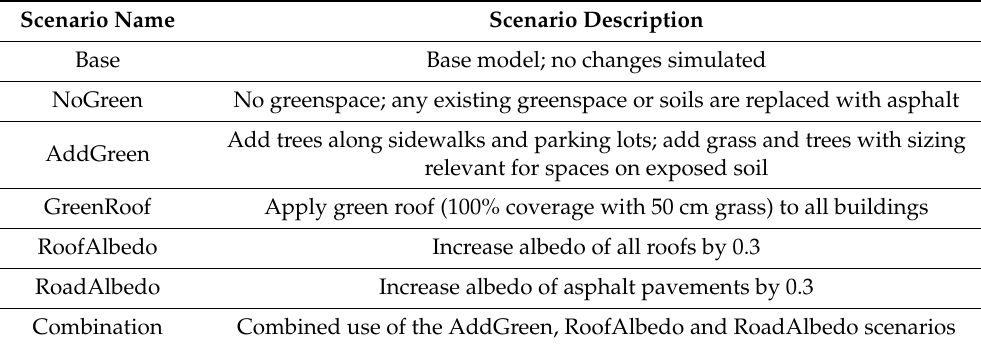
Table 5. The seven scenarios modeled for each of the six cluster types. These include the base scenario, for which no changes were simulated and to which other scenarios were compared, as well as six design interventions.